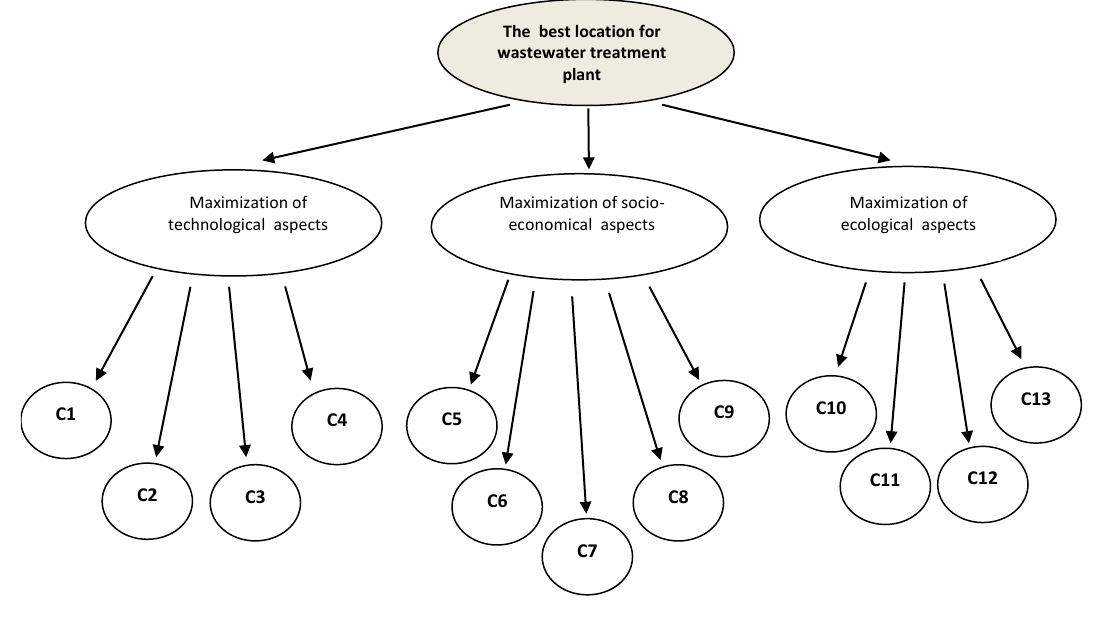
Figure 3. Hierarchical structure of goals and criteria. Table 1. Criteria-labels, names, short descriptions, and preferences. WWTP, wastewater treatment plant.